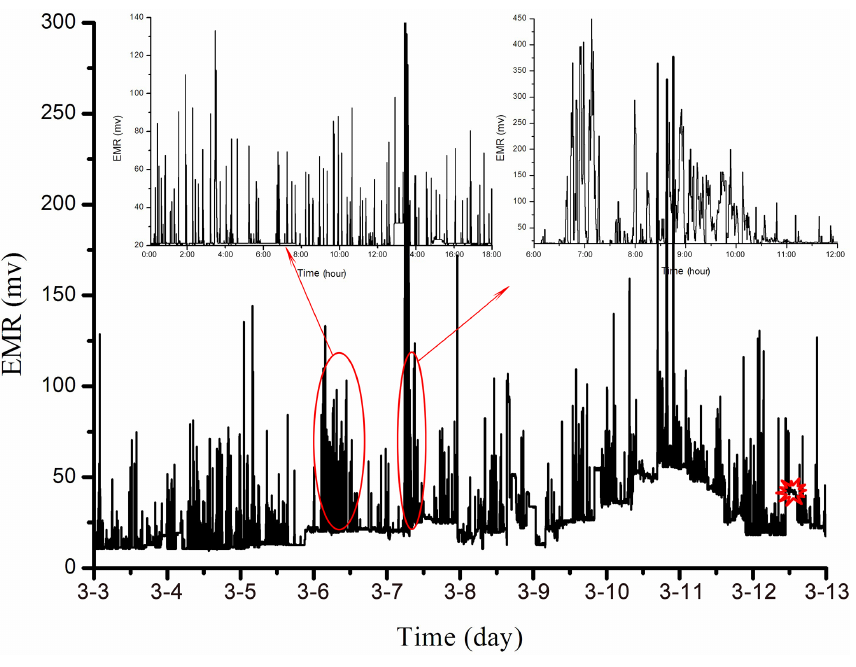
Figure 5. Dynamic variation of EMR from coal rock at the mining roadway of Coal Mine A before and after the rock burst occurred before dawn on 12 March 2013.